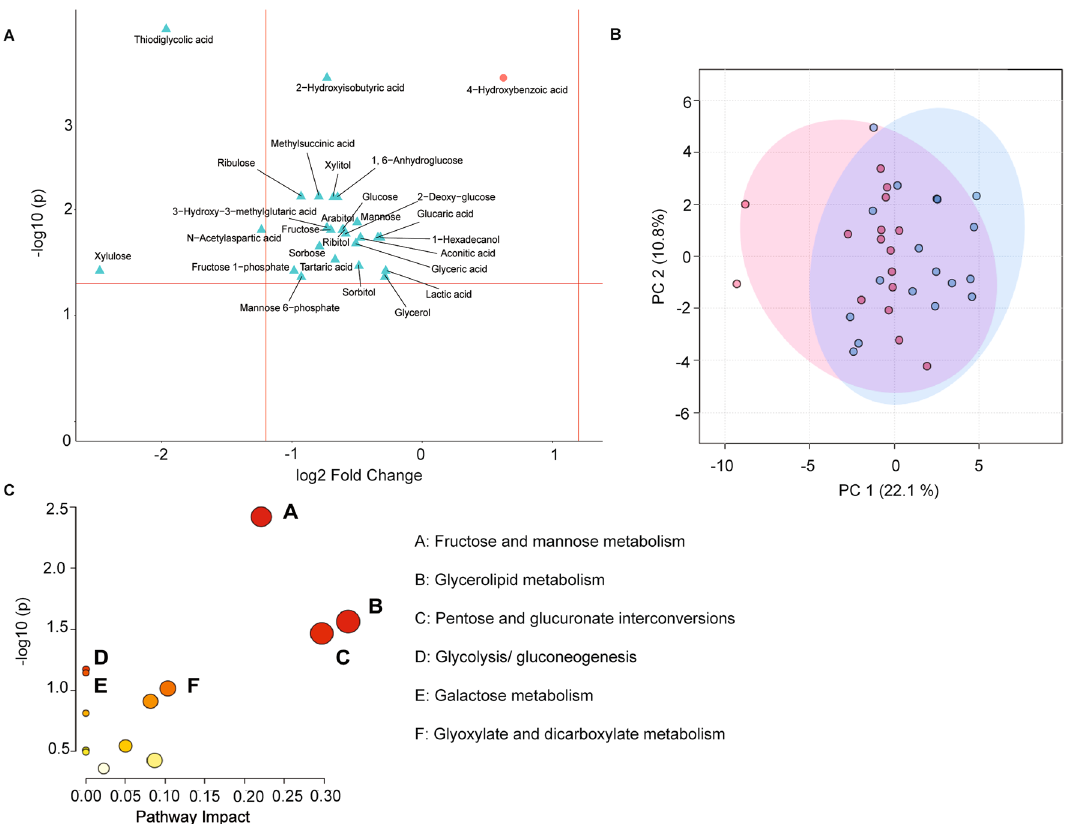
Figure 3. ( A ) Volcano plot of differentially expressed (FDR adjusted P ≥ 0.05) liver metabolites from lambs fed the carrot (red; positive log2 FC) and control (blue; negative log2 FC) diet. Twenty-seven liver metabolites were influenced by diet and reflected by log2 fold change as determined by t-test ( P < 0.05). ( B ) Separation of liver metabolic profiles via principal component analysis for liver samples from control (red) and carrot-fed (blue) lambs. ( C ) Pathway analysis of liver metabolites enriched via MetaboAnalyst 5.0 associated with the Bos taurus KEGG pathways. Pathways ( A–C ) with an impact value ≥ 0.1 and P -value ≤ 0.05 are considered biologically relevant, and tendencies (0.05 ≥ P ≥ 0.10; ( D–F )) were illustrated. Circle size indicates the magnitude of the pathway impact value, defined as the cumulative value of significant metabolites. Colour is indicative of P -value, where red = P < 0.05 and ranges to white = P > 0.05 (Supplementary Table S3).